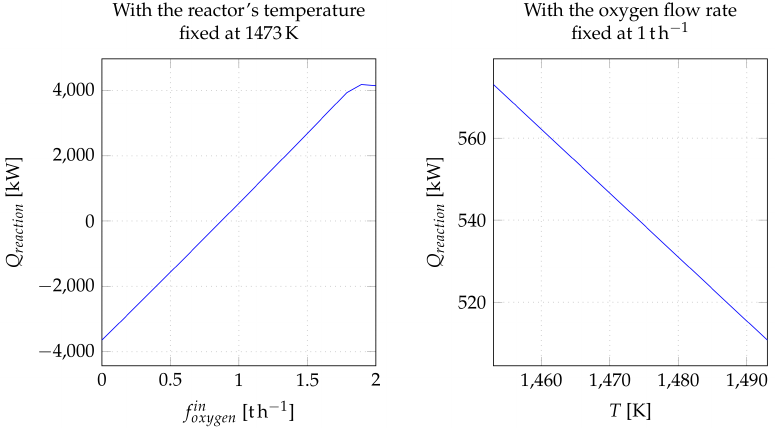
Figure 19. Power resulting from the gasification reaction as a function of oxygen flow rate variations ( left ) and reactor’s temperature variations ( right ).